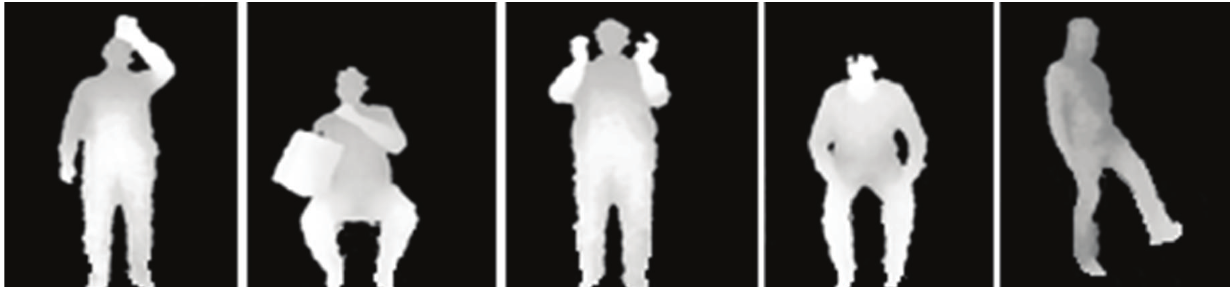
Figure 11: Examples of depth activities images used in IM-DailyDepthActivity dataset.